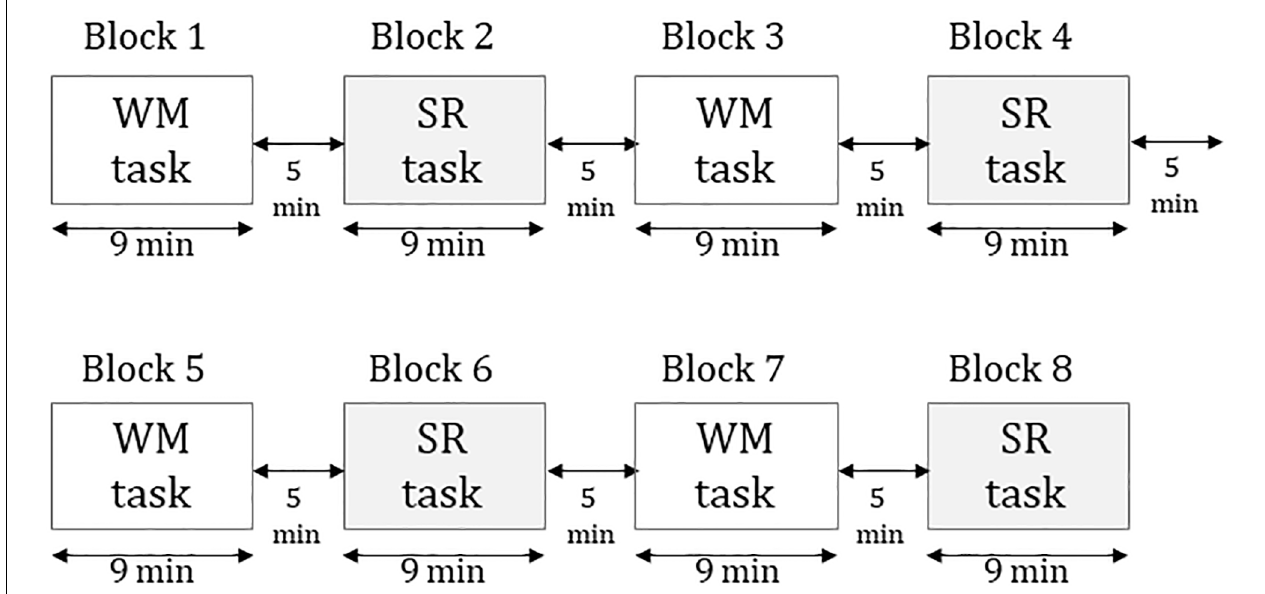
FIGURE 1 | The procedure of the experiment consists of eight blocks in which four were working memory tasks and four were self-reflection